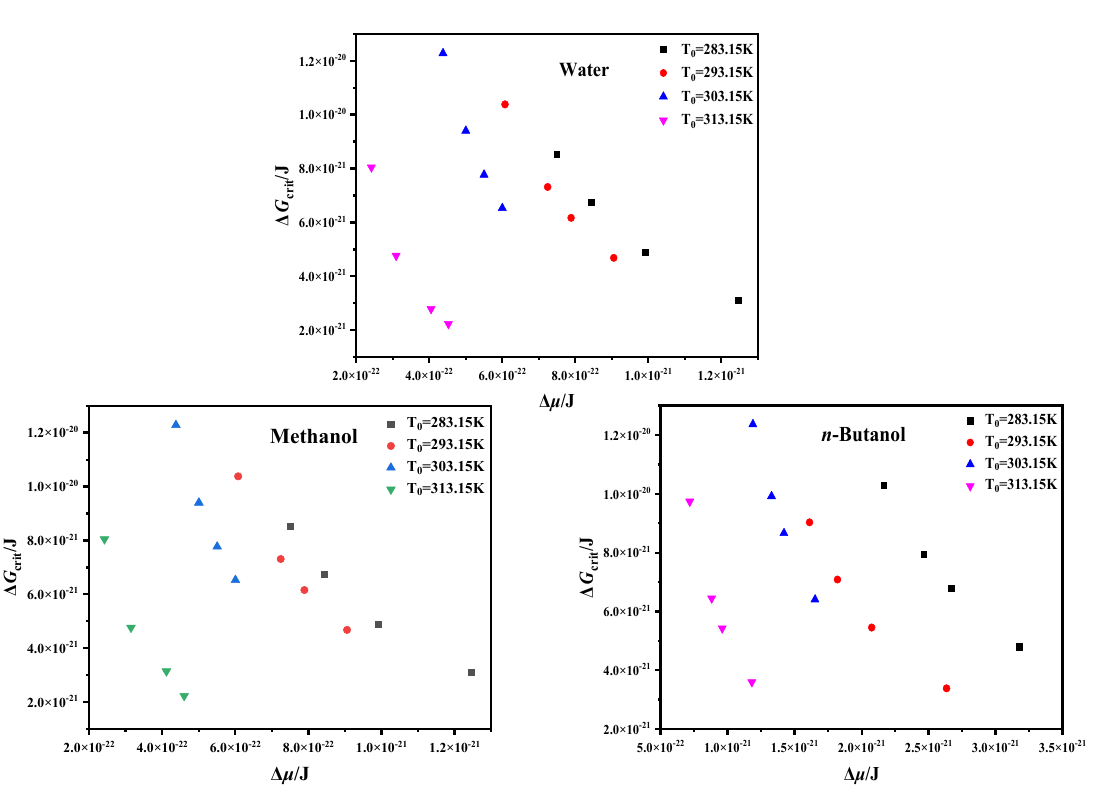
Figure 9. Relationships between driving force and nucleation Gibbs free energy.